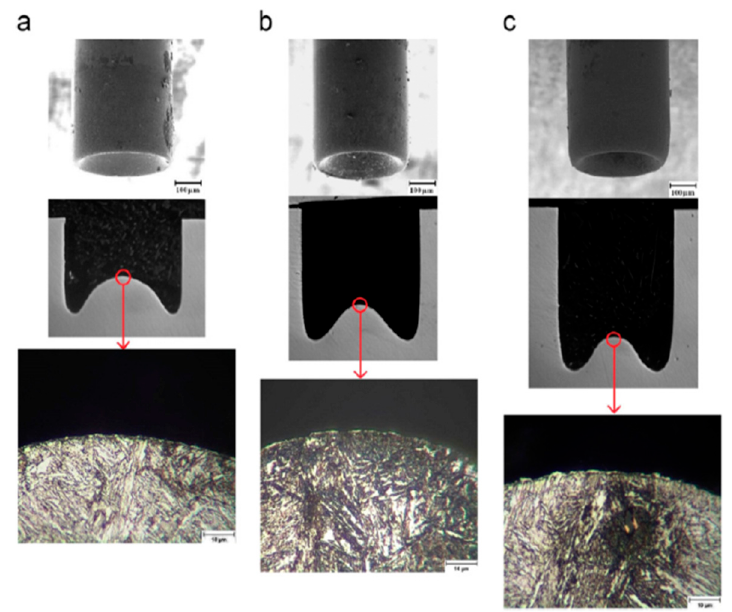
Figure 14. Micro-tool electrodes and optical section views of machined micro-holes using very short pulses and open gap voltages of ( a ) 60 V, ( b ) 75 V, and ( c ) 90 V [185].